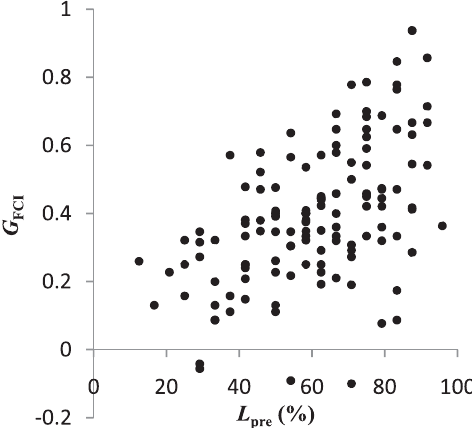
FIG. 5. Scatter plot for the students’ ( n ¼ 131 ) Lawson pre- score ( L pre ) and the single student normalized FCI gain ( G FCI ). Spearman’s rank correlation is 0.52 ( p < 0 : 001 ).